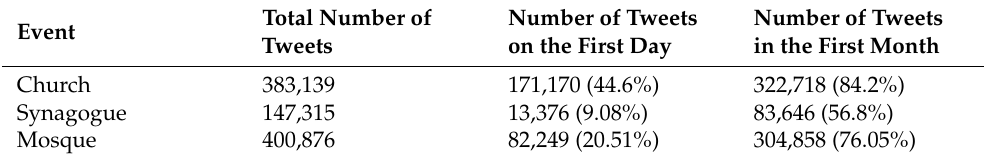
Table 4. Tweet percentage over time.